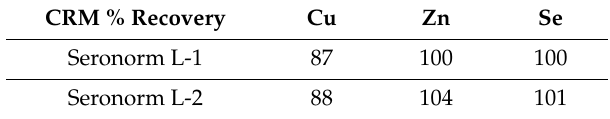
Table A2. Average recovery (%; n = 4) for three elements compared to accredited